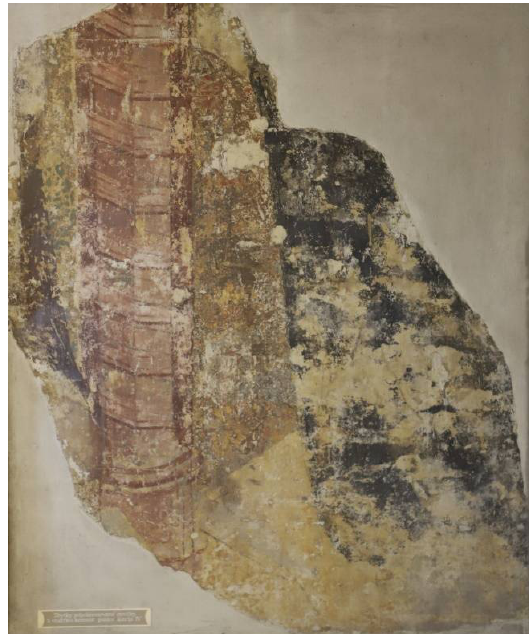
Figure 5. Prague Castle, transfer of decorative paintings Vladislav Hall, today in the depository of Prague Castle. Photo by František Záruba, the author’s own work.